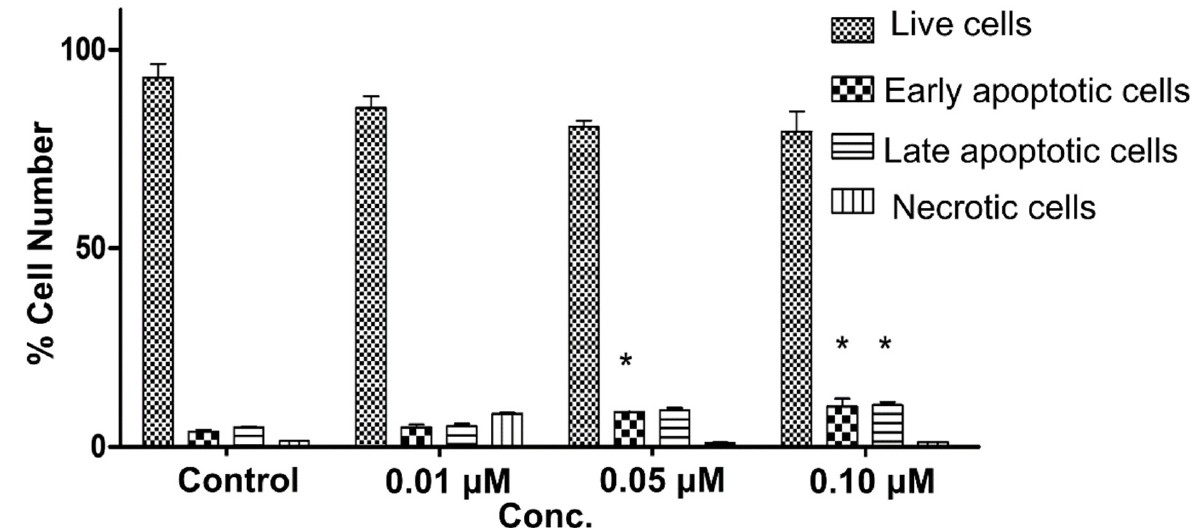
Figure 14. Bar graph showing the effect of compound 16g on apoptotic events in MCF7 cells (72 h) after staining with annexin V and PI; x -axis: concentration, y -axis: % cell number. Data shown are % mean ± SD ( n = 3). The experiment was repeated 3 × . after treatment with the test compound at 0, 0.01, 0.05, and 0.10 µ M ( n = 3), statistical differences, compared with control cells, were assessed by one-way ANOVA with the Tukey’s post-hoc multiple comparison test (GraphPad Prism). p < 0.05 (*) was taken as significant.